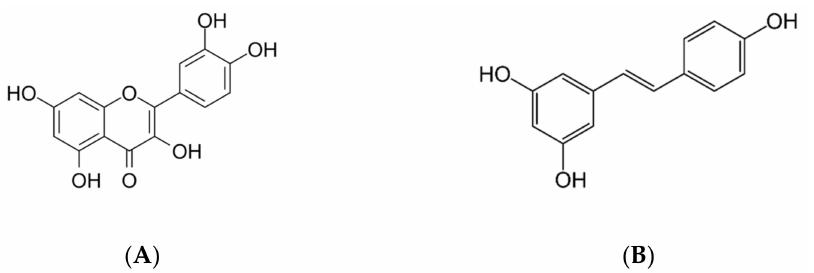
Figure 7. Molecular structures of two polyphenols: quercetin ( A ) and resveratrol ( B